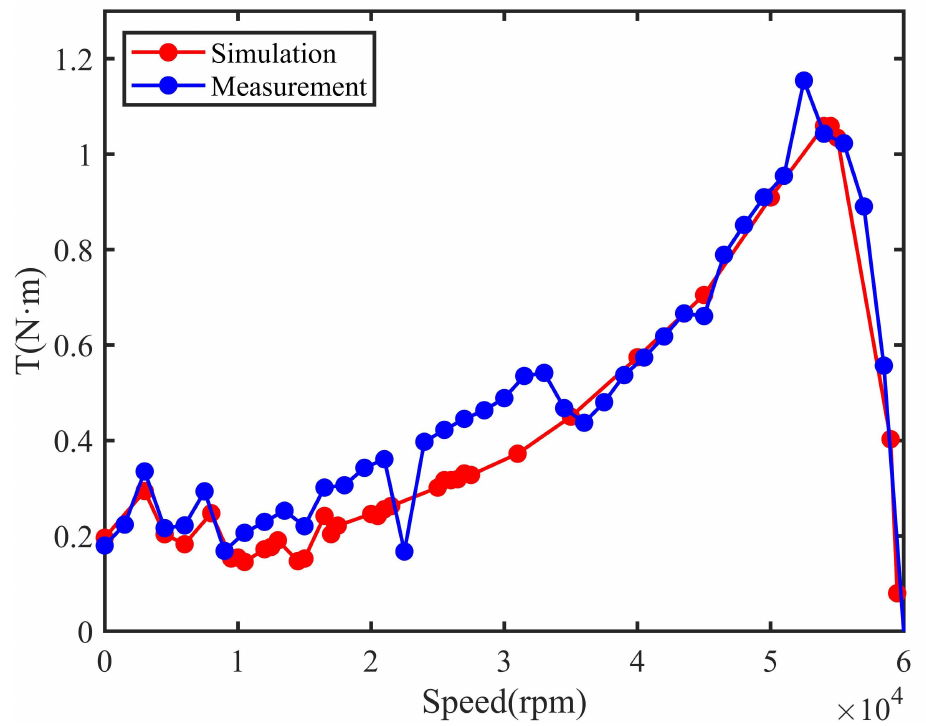
Figure 18. Comparison of Speed-Torque